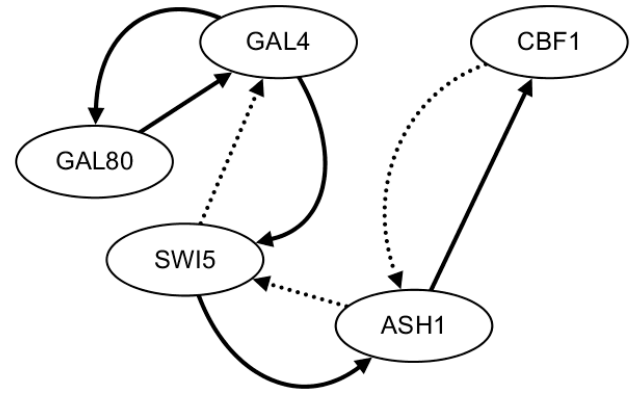
Figure 6. The inferred IRMA network with off dataset. The solid lines represent the true regulatory relationships and the dotted lines are the false positive regulations inferred.